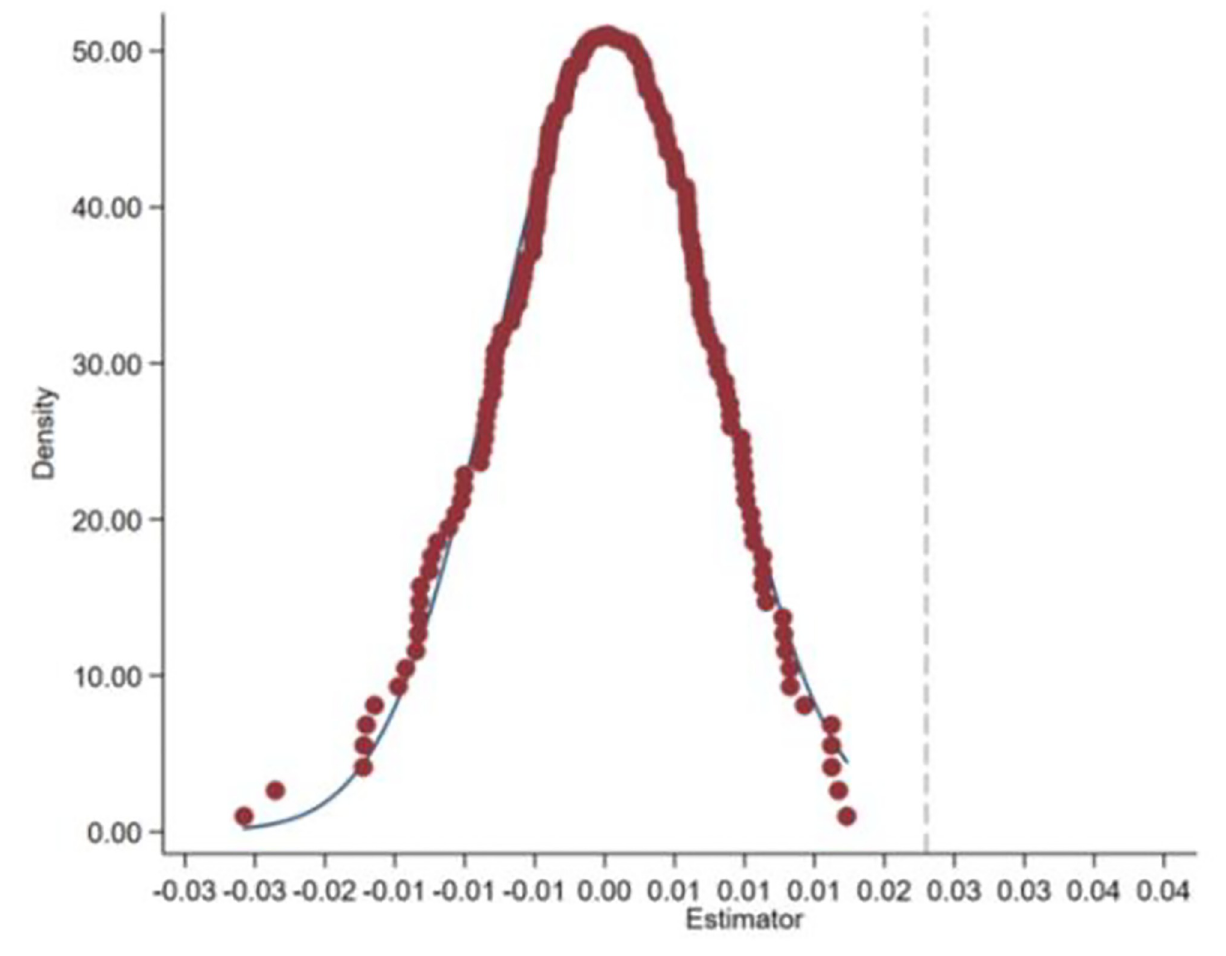
Fig 1. Placebo test of VC Quan Zi and asset